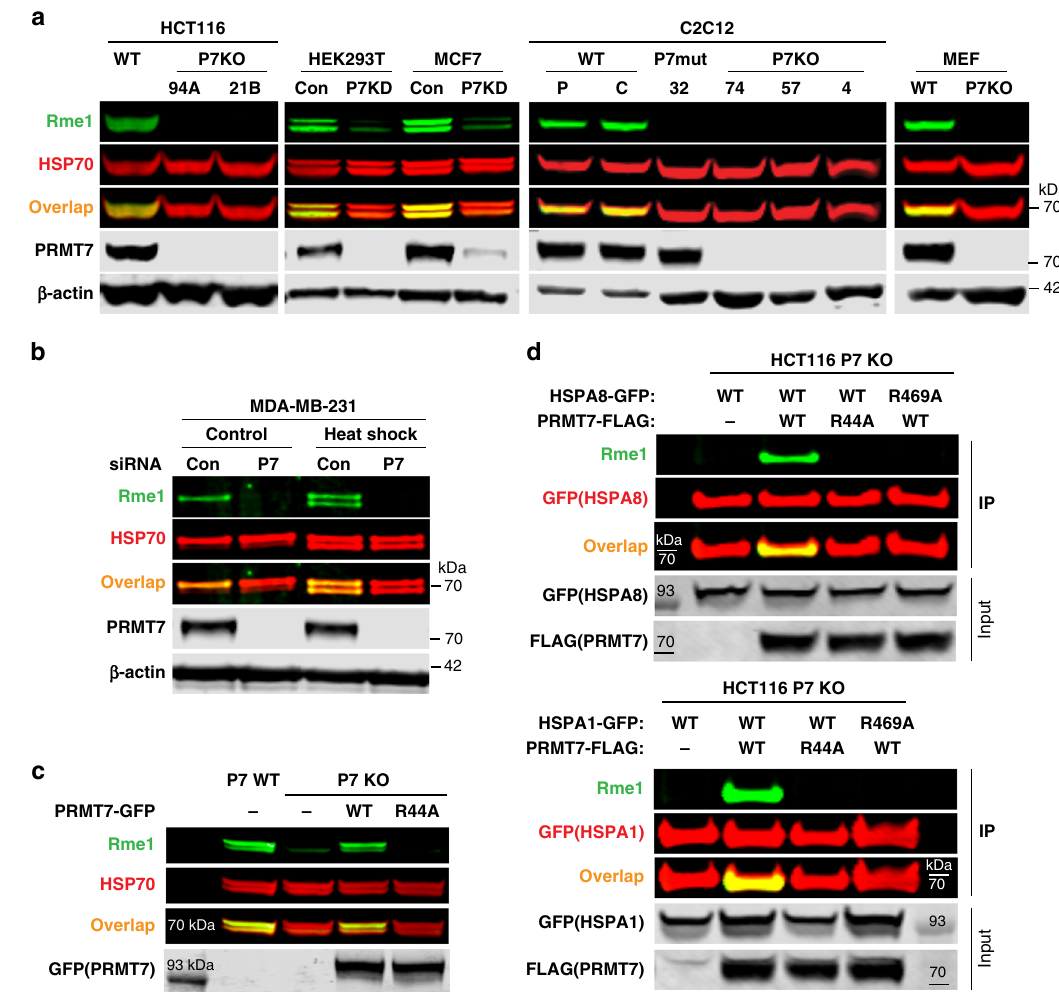
Fig. 3 HSP70 R469 is methylated by PRMT7 in cells. a PRMT7 (P7) knockout (KO) or knockdown (KD) reduces HSP70 methylation in various cell lines. 94A, 21B — HCT116 CRISPR PRMT7 KO clones; P parental C2C12; C-C2C12 expressing control guide RNA; 32 C2C12 CRISPR clone expressing PRMT7 catalytic mutant (delY35,A35S); 4,57,74 — C2C12 CRISPR Prmt7 KO clones. PRMT7 was knocked down in HEK293T and MCF7 cells using siRNA, Con control, P7KD PRMT7 knockdown. b Monomethylation of inducible and constitutive HSP70 is PRMT7-dependent. MDA-MB-231 cells were transfected with PRMT7 siRNA for 3 days, heat-shocked for 1 h at 42 °C and analyzed 24h after heat shock. c Only wild-type PRMT7 is able to rescue the HSP70 arginine monomethylation in HCT116 PRMT7 KO cells. Cells were transfected with GFP-tagged PRMT7 WT or catalytic mutant (R44A). d HSP70 R469A mutation blocks PRMT7-mediated methylation of HSPA8 and HSPA1. HCT116 PRMT7 KO cells were co-transfected with FLAG-tagged PRMT7 WT or R44A mutant and GFP-tagged HSPA8 or HSPA1 WT or R469A mutant. HSPA1/8-GFP was immunoprecipitated and analyzed for arginine monomethylation levels. The HSP70 methylation in MCF7, HCT116, and HEK293T cells was analyzed in cytoplasmic fraction to avoid unspeci fi c band overlap.